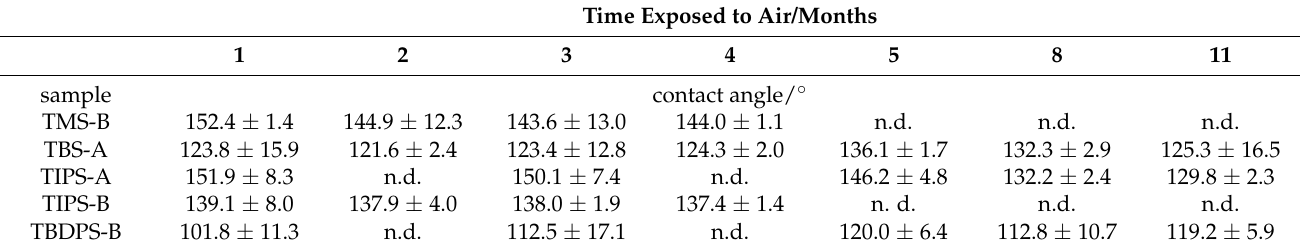
Table 4. Dynamic contact angles, as determined using the Wilhelmy